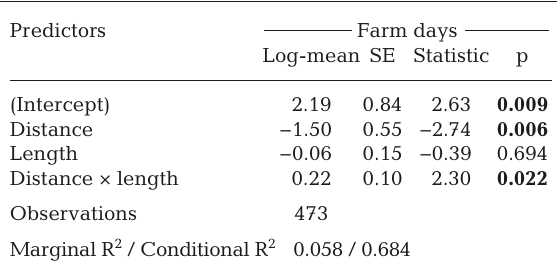
Table 5. Negative binomial model on the number of days cod spent at a salmon farm as a function of Euclidean dis- tance from release point to farm and fish length. Only fixed effects are shown. Significant p-values are shown in bold